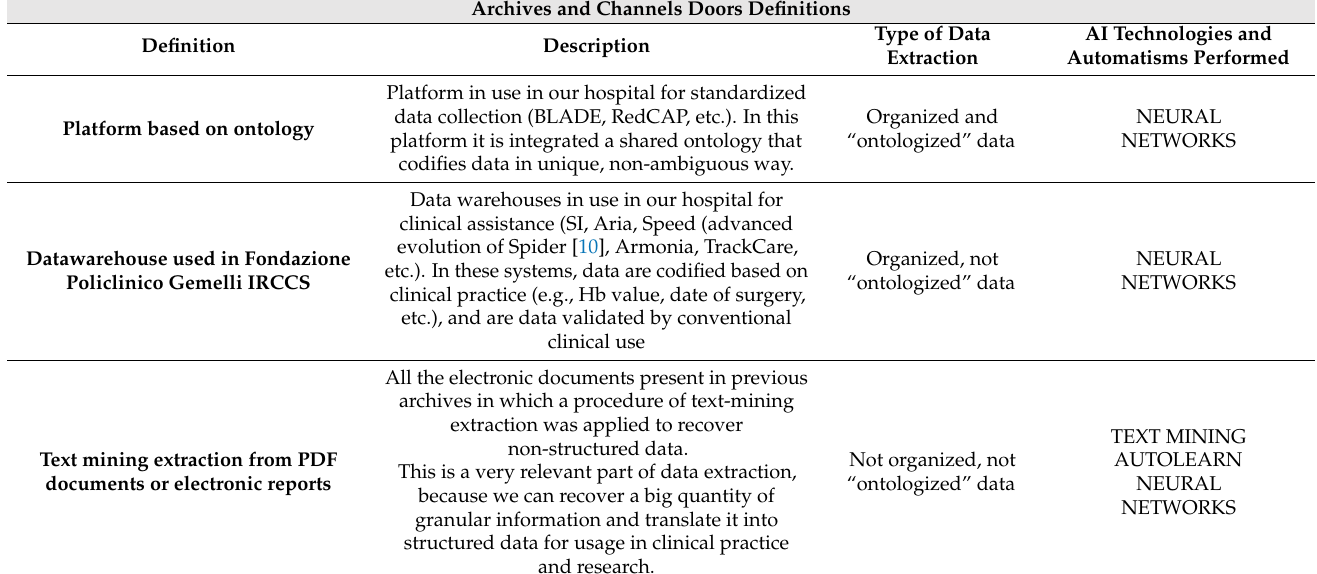
Table 2. Archives and channels doors